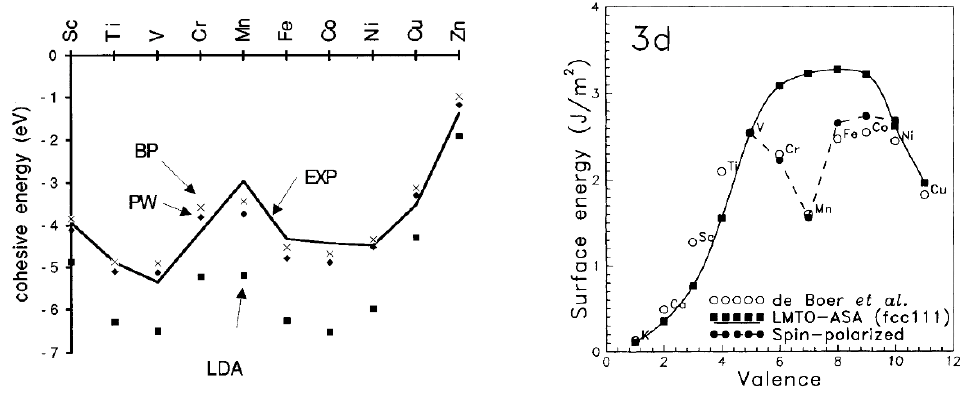
Figure 6. ( Left ): Trend of the experimental (black solid line) and calculated cohesive energies for the 3d metal period. Solid squares, solid rhombs and crosses indicate the LDA (local density approximation), PW (generalized gradient approximation (GGA), Perdew-Wang, PW91) and BP (GGA, Becke-Perdew) functionals used to calculate the cohesive energy values, respectively. Reprinted figure with permission from P.H.T. Philipsen and E.J. Baerends, Physical Review B, 54, 8, 5326–5333, 1996. Copyright 1996 by the American Physical Society. https://doi.org/10.1103/PhysRevB.54.5326 [90]. ( Right ): Trend of experimental surface energies, derived from surface tensions measurements of liq- uid metals (open circle), and calculated surface energies for the 3d -period. Solid squares indicate the surface energies obtained from paramagnetic calculations of fcc (111) surfaces for all the 3d -periods, while solid circles indicate those obtained from spin-polarized calculations of Cr (bcc (100)), Mn (bcc (100)), Fe (bcc (110)), Co (hcp (001)) and Ni (fcc (111)) surfaces. Reprinted figure with permission from M. Ald é n, H.L. Skriver, S. Mirbt and B. Johansson, Physical Review Letters, 69, 15, 2296–2298, 1992. Copyright 1992 by the American Physical Society